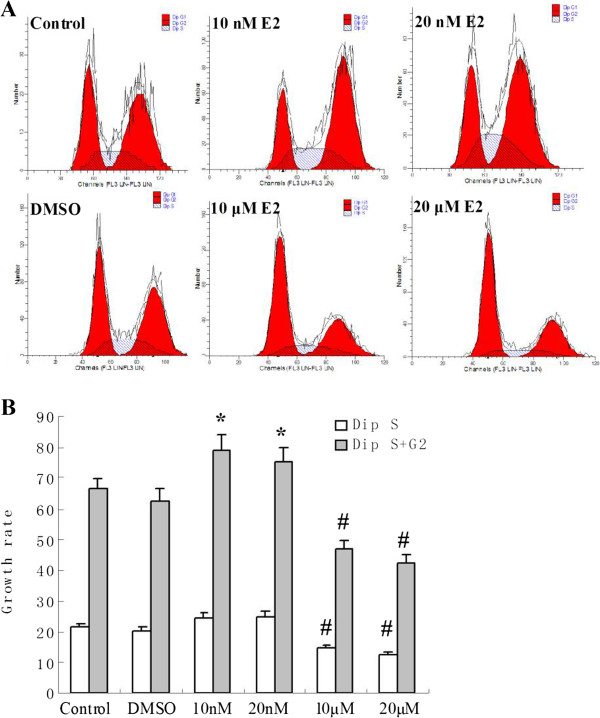
Effects of different doses of E2 on cell proliferation of cultured PC12 by flow cytometric analysis. (A) The first red peak, the arc-shaped hatched portion in the middle and the second red peak represent G1 phase, S phase and G2 phase of cell cycle, respectively. (B) 10 nM and 20 nM E2 treatment did not induce a significant increase in the percentage of the S phase cells of the cell cycle, but induced a significant increase in the percentage of cells in S + G2 phase. 10 μM and 20 μM E2 treatments significantly decreased the percentage of cells in both S phase and S + G2 phase of the cell cycle (*p < 0.01 v.s. the control and DMSO groups, #p < 0.05 v.s. the control and DMSO groups). Dip: diploid.